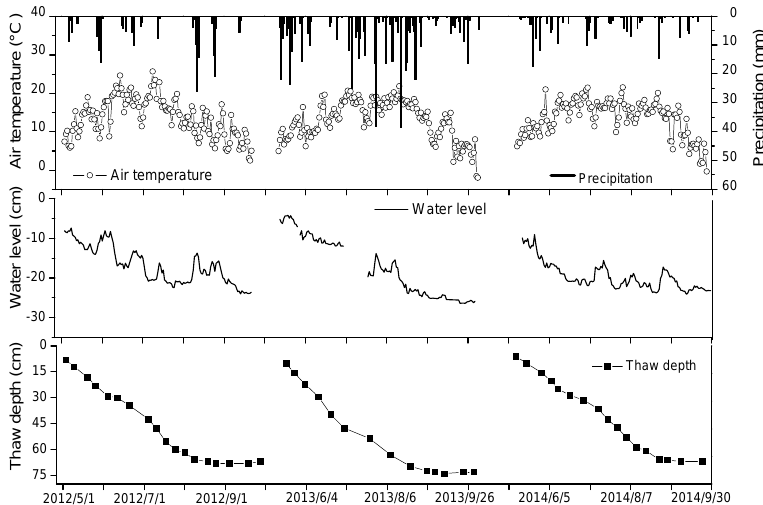
Figure 2. Air temperature, precipitation, water levels and thaw depth in peatland observed during the growing seasons of 2012 to